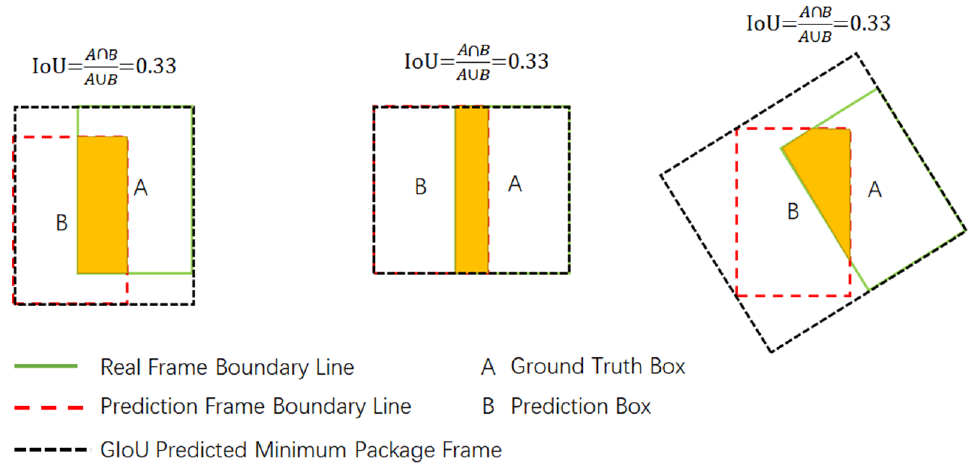
Figure 7. The Interest over Union (IoU) is the same, but the coincidence degree is di ff